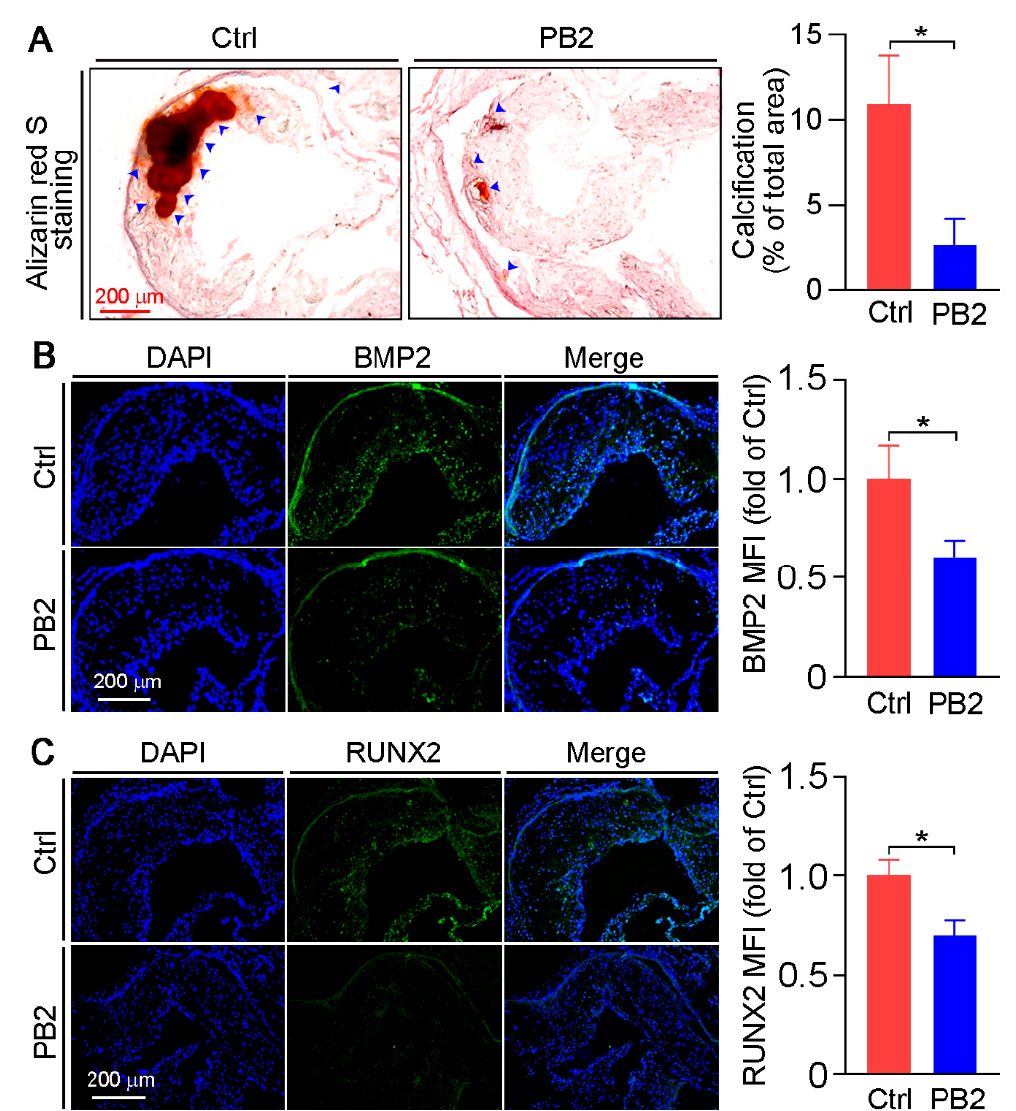
Figure 3. Procyanidin B2 reduces vascular calcification in apoE − / − mice by inhibiting BMP2 and RUNX2 expression. ( A ) Aortic root cross sections were conducted alizarin red S staining to determine calcification with the quantitative analysis of calcification-positive areas. * p < 0.05 (10 mice per group were used, and at least three samples from each mouse were taken as technical replicates). The expression of BMP2 ( B ) and RUNX2 ( C ) in aortic root cross sections was determined by immunofluorescent staining with the quantification of positive areas. * p < 0.05 (10 mice per group were used, and at least three samples from each mouse were taken as technical replicates).